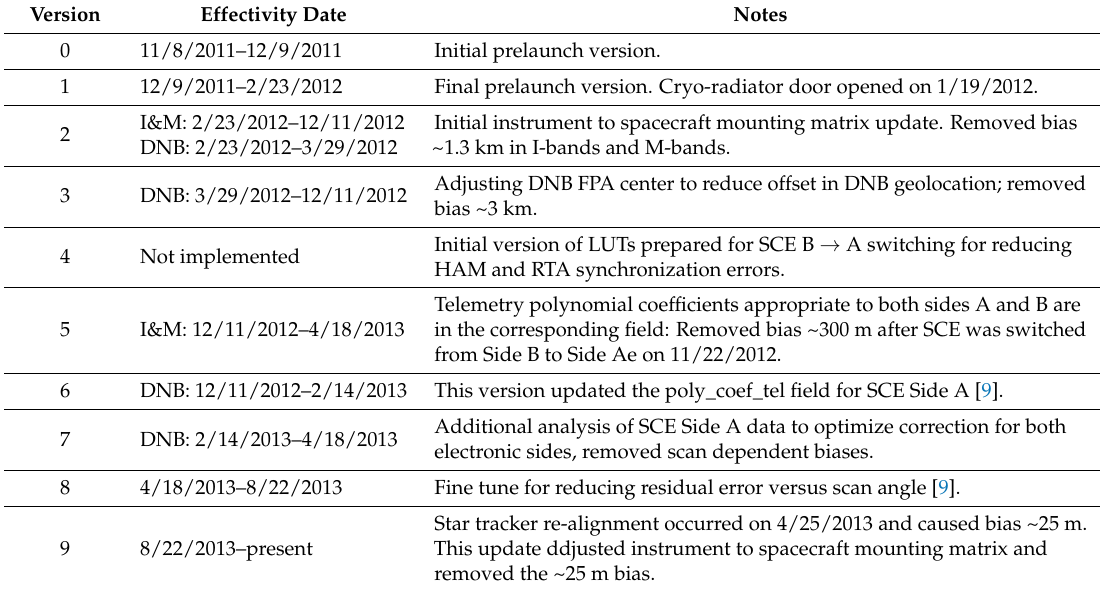
Table 2. S-NPP VIIRS geometric parameter look-up table update